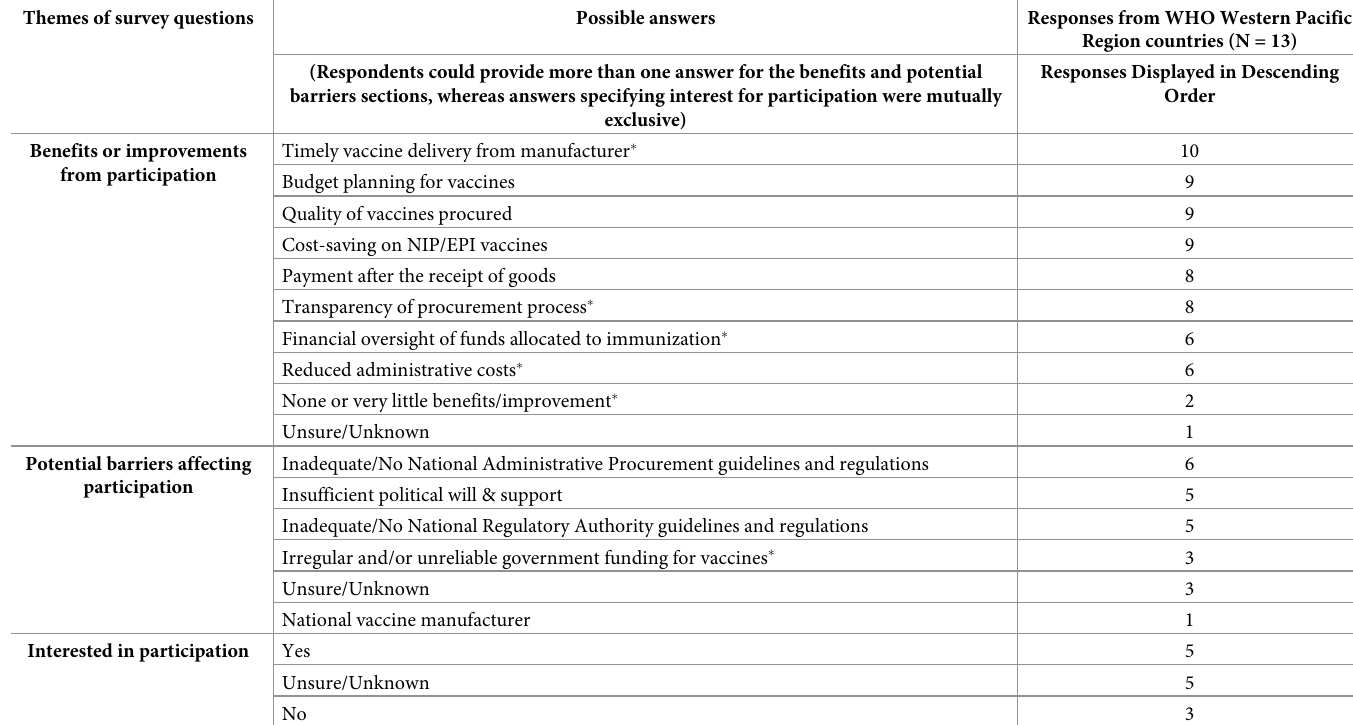
Table 3. Summary of perceptions on having a regional pooled procurement mechanism for vaccines in the World Health Organization (WHO) Western Pacific Region. Themes of survey